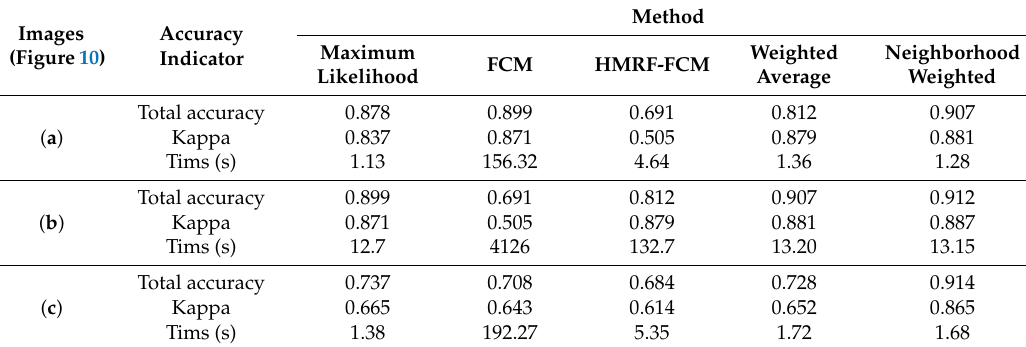
Table 3. The real high-resolution remote-sensing images